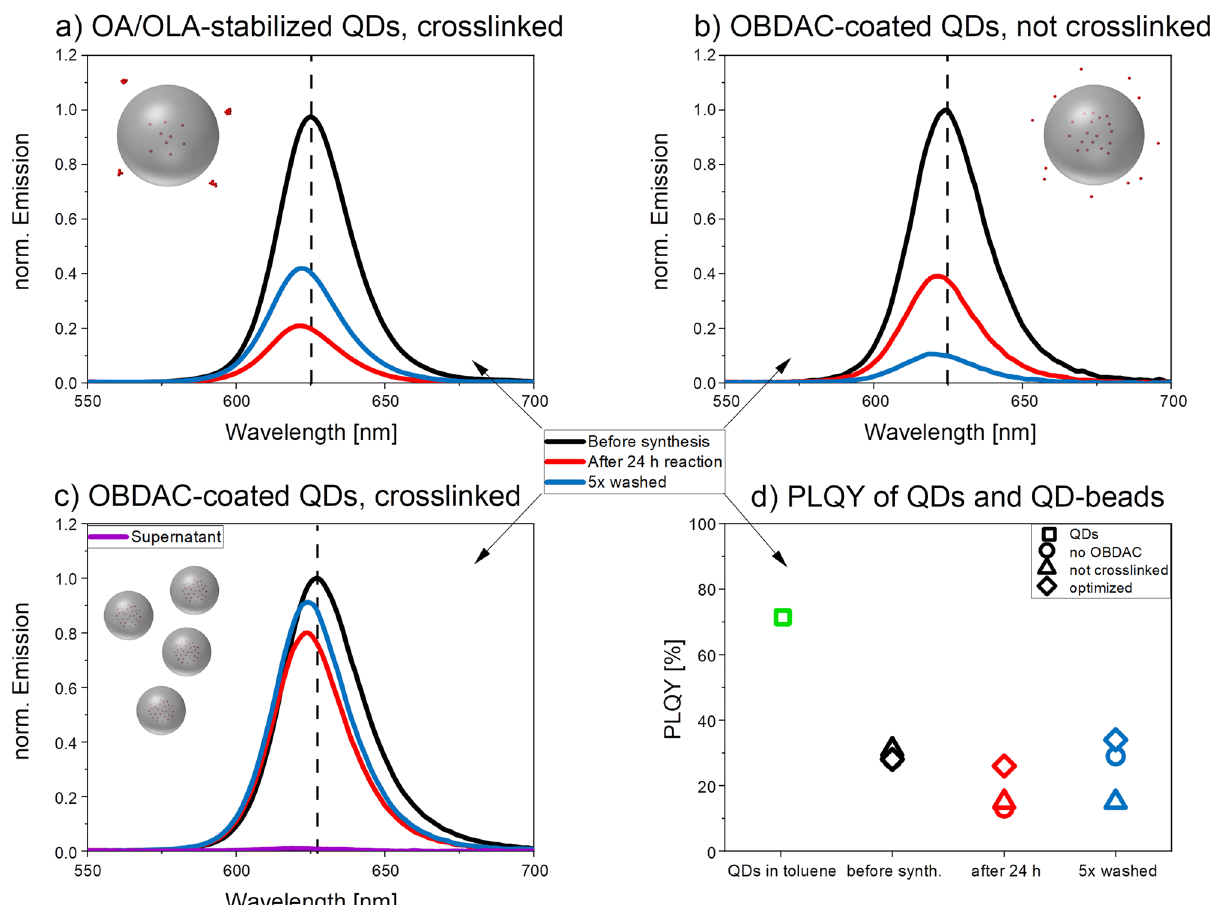
Figure 4. Emission spectra (λ exc = 350 nm) of CdSe/CdS-QDs in the reaction mixture before the polymerization reaction and the resulting QD-encoded PS microbeads in ethanol, obtained for ( a ) OA/OLA-stabilized QDs, crosslinked with DVB, ( b ) OBDAC-coated, OA/OLA-stabilized QDs without crosslinking, with PEG- b -PCL, ( c ) for optimized conditions, i.e., OBDAC-coated, OA/OLA-stabilized QDs, addition of PEG- b -PCL, and crosslinking with DVB, and ( d ) the corresponding PLQY values obtained at different reaction stages and for the initial QDs. Conditions used for the preparation of the QD-encoded PS beads: 75 °C, 36.6 mg AIBN, 36.6 mg PEG- b -PCL, 70 rpm stirring speed, and 24 h reaction time. For the comparison of the PL spectra, the emission intensity of the QDs in the initial reaction mixture was always set to one and the other spectra were scaled accordingly. The observed shift of the emission maxima is attributed to the change in QD environment from initially styrene/ethanol to polystyrene after the polymerization reaction. The increase in PL intensity of the beads in panels ( a , c ) washed 5 times with ethanol compared to the PL of the beads after a reaction time of 24 h is attributed to a slight change in bead concentration and bead loss during the washing steps as revealed by the corresponding absorption spectra displayed in the SI (Fig.